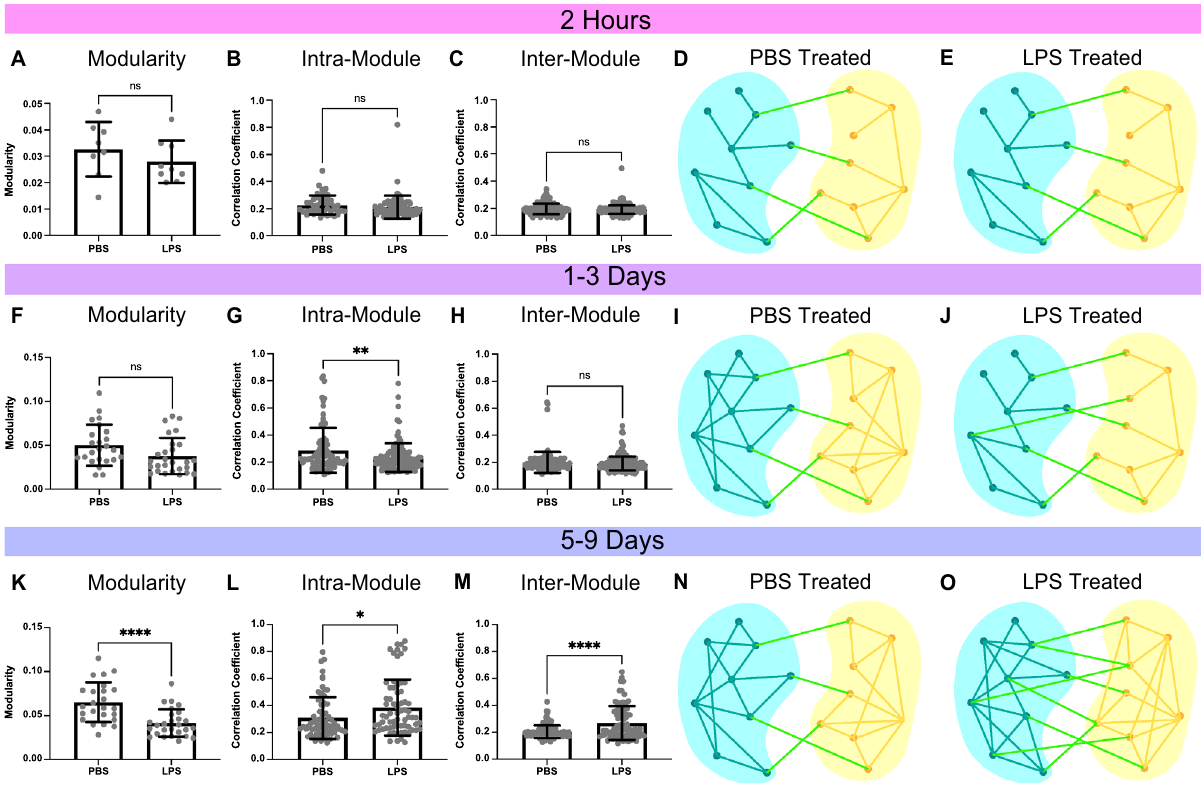
Figure 6. LPS disrupts community structure at 5–9 days after exposure. At 2 h after treatment, there was no significant difference ( p = 0.3074) between PBS and LPS in modularity ( A ), including no difference in the intra-modular ( p = 0.3056, B ) or inter-modular ( p = 0.056, C ) correlation coefficients. Schematic representations of connectivity data display the stronger intra-modular connections in blue (module 1) and yellow (module 2) than inter-modular connection (green) for both PBS treated ( p < 0.0001, D ) and LPS treated ( p < 0.0001, E ) samples at 2 h, a. At 1–3 days after treatment, there was no significant difference ( p = 0.0505) between